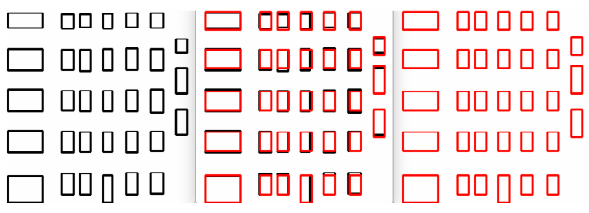
Figure 5. Original and optimized layout of 33 detected windows.